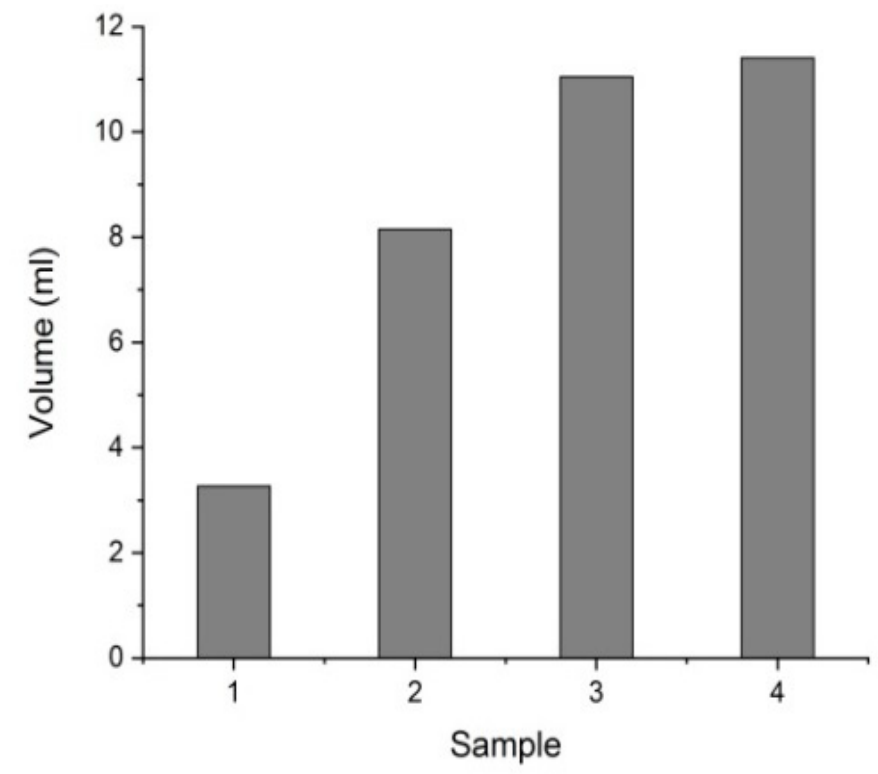
Figure 3. Total volume obtained from experiments in this research (1: 0.1% (Al 2 (SO 4 ) 3 ) with Cu 2 + , 2: 0.1% (Al 2 (SO 4 ) 3 ) with Cu 2 + , 3: 0.3% (Al 2 (SO 4 ) 3 ) with Cu 2 + , 4: the solid phase after separation). Table 1. Characteristics of the liquid phase separated from the mixed phase with solid.